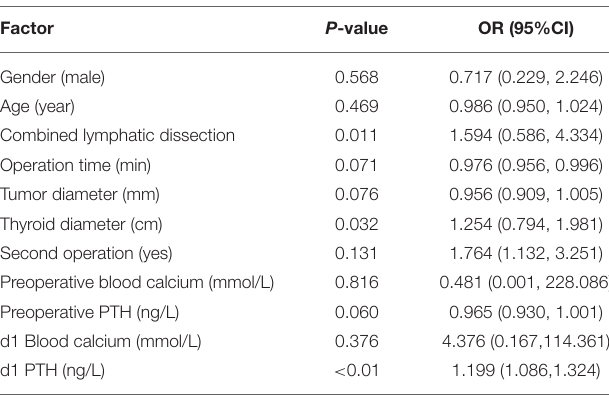
TABLE 3 | Multivariate logistic regression analysis results of long-term